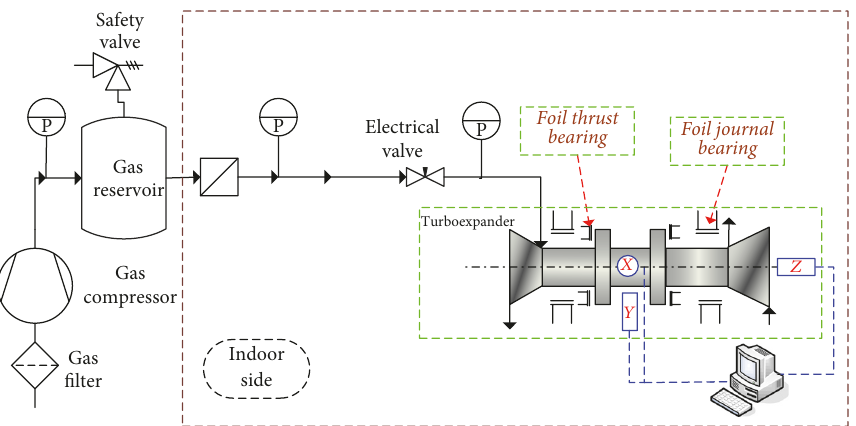
Figure 3: Flow chart of high pressure gas driven turboexpander test rig.